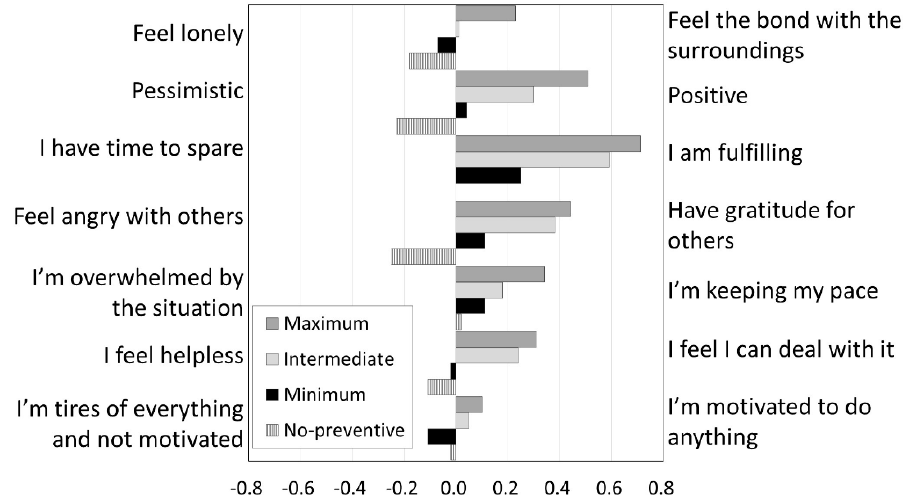
Figure 2. Feelings in daily life.